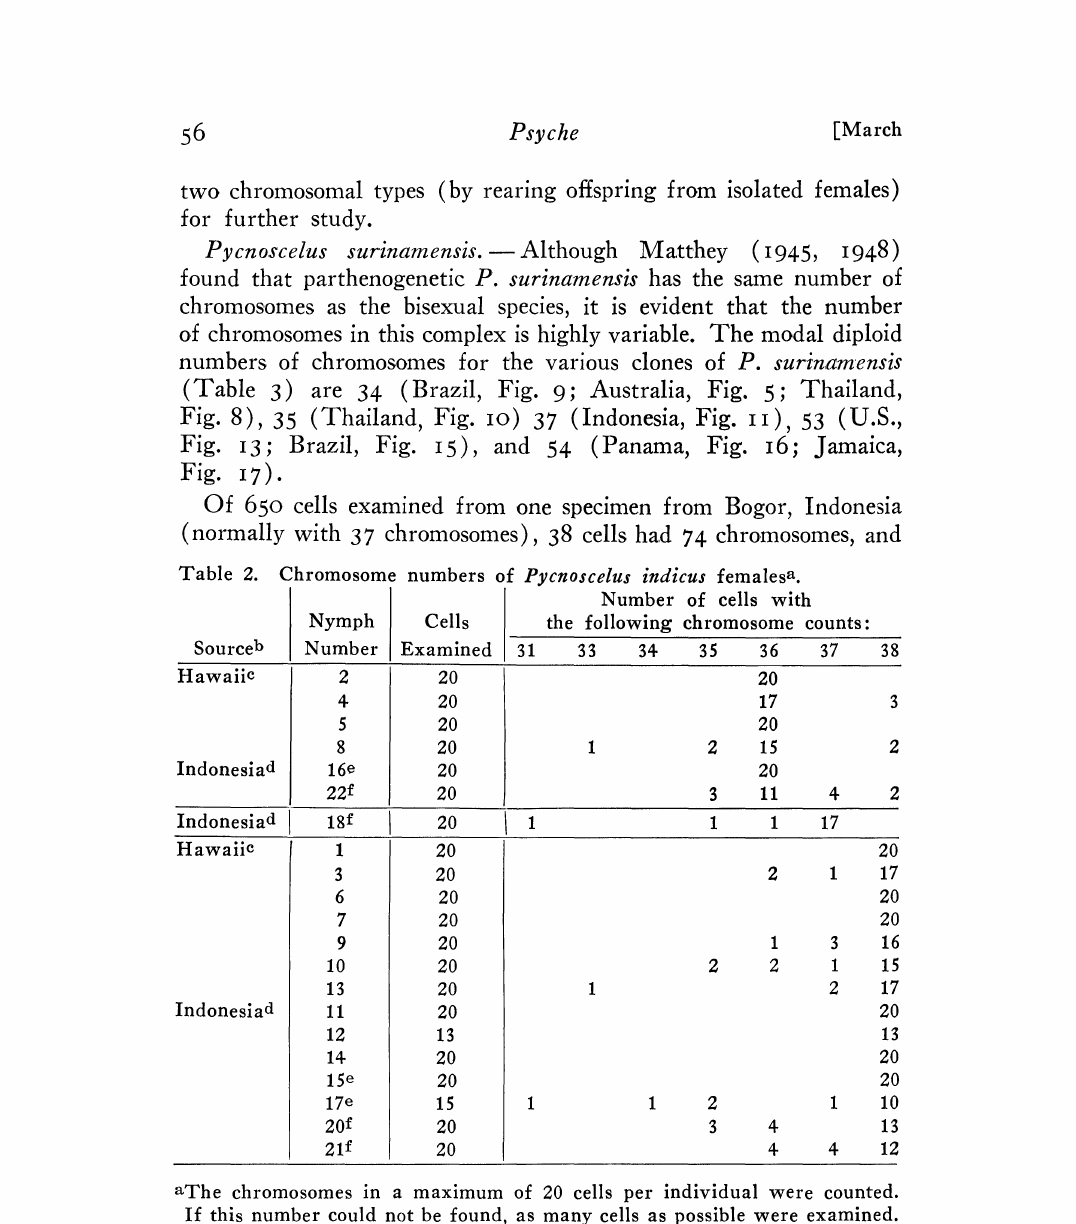
two chromosomal types (by rearing offspring from isolated females) for further study.